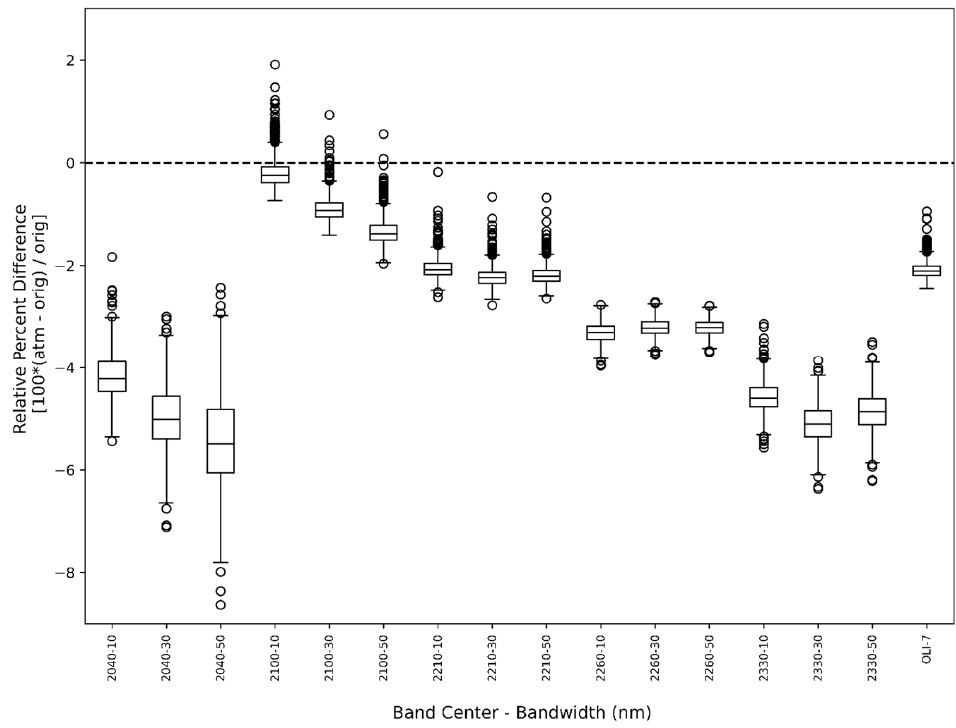
Figure 3. Relative percent difference of reflectance between original (org) and atm spectra, indicating residual atmospheric interference for five SWIR bands, at bandwidths of 10, 30, and 50 nm, as well as OLI Band 7, at 180 nm bandwidth. The x axis indicates band center wavelength followed by bandwidth (nm). The generally negative RPD values are unique to the correction scheme in [43]. The relative differences between bands provides a performance metric of robustness to atmospheric constituents with 2040 nm band being notably impacted by CO 2